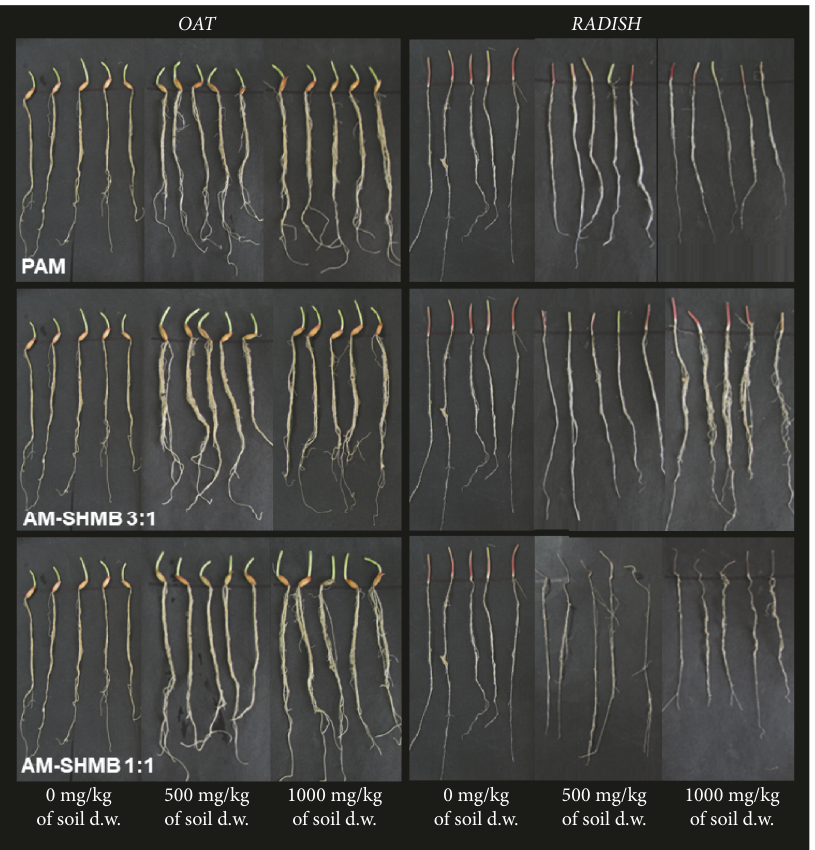
Figure 4: Digital photographs of roots of oat and radish growing in the presence of PAM and Tulipalin A-based